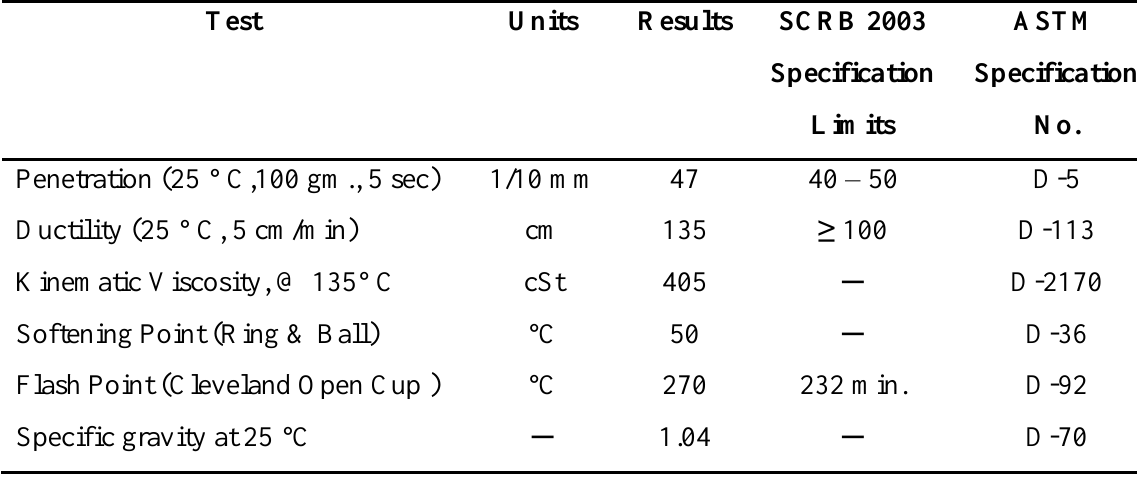
Table. 2. Physical Properties of the used asphalt